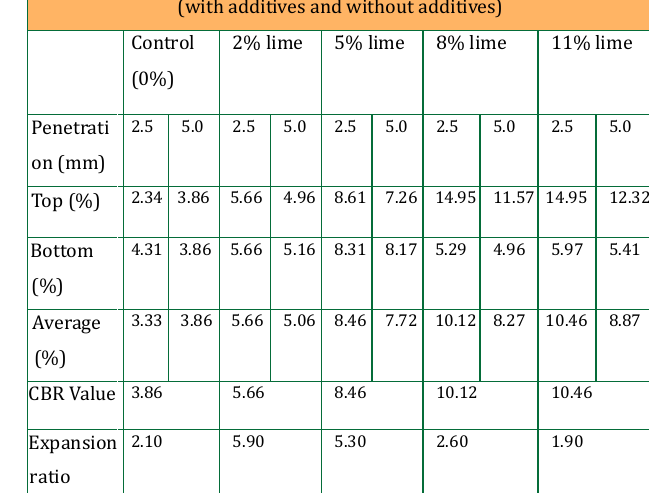
Table 6 (b): summary of soaked CBR values for the clay soil sample (with additives and without